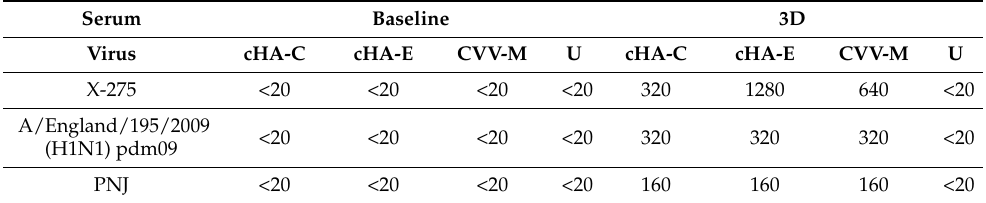
Table 4. Baseline/sero-converted blood assessment to influenza A (H1N1)